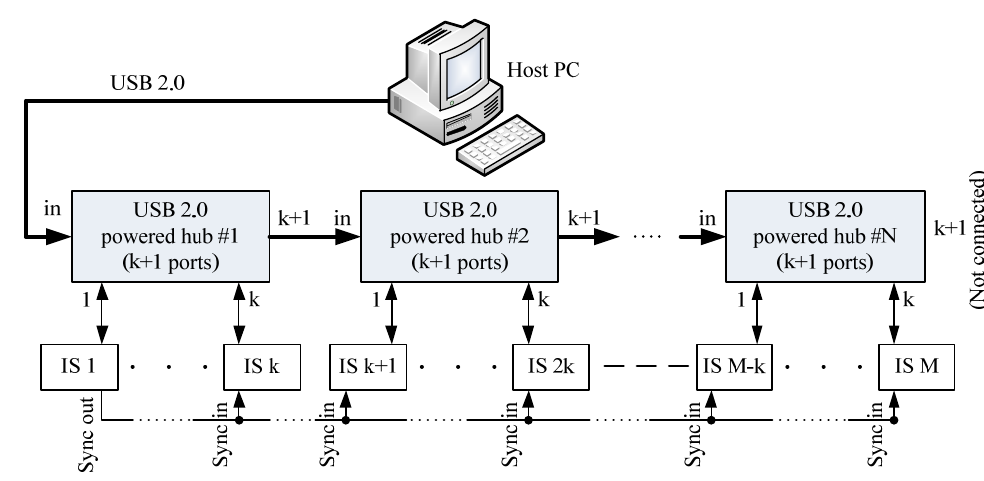
Figure 3. Proposed system architecture: general